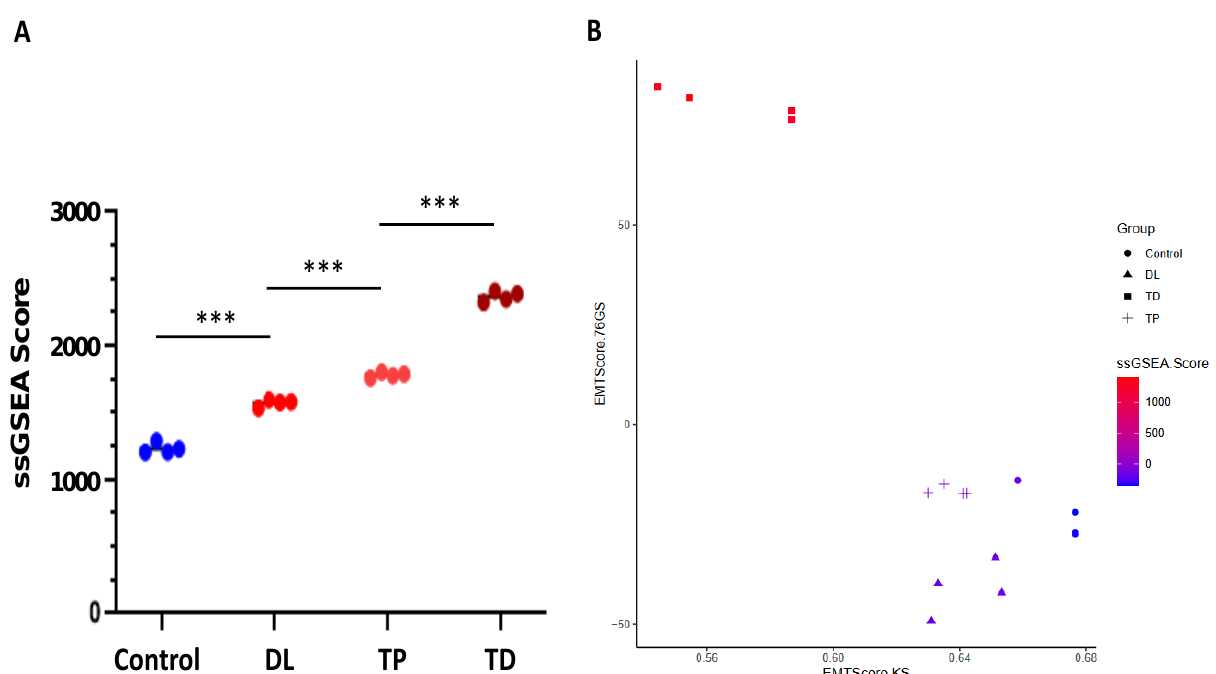
Figure 14. Apoptosis and EMT scoring . The X -axis represents the 76 gene signature scores, and the y -axis describes the Kolmogorov–Smirnov test scores. ( A ) ssGSEA scoring of hallmark apoptosis pathway, ( B ) EMT scoring: Dot shape indicates group, and dot color indicates ssGSEA score for EMT. ssGSEA: Single-sample gene set enrichment analysis. *** p < 0.001, DL: Dl-sulforaphane; TP: TP472; TD: